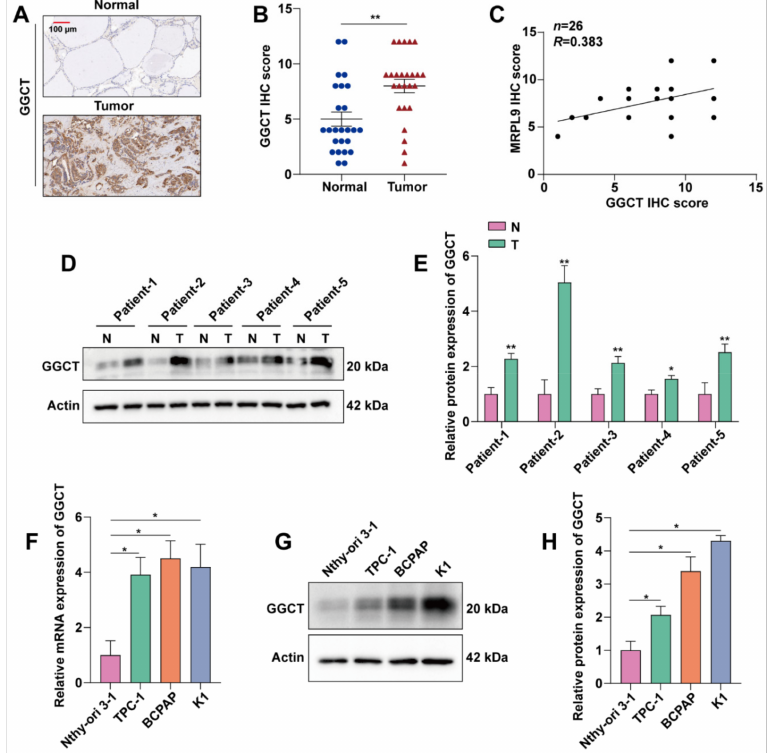
Figure 4. GGCT is highly expressed in PTC. ( A ) Representative images of GGCT immunohisto- chemistry (IHC) of normal PTC tissue (left) and PTC tissue (right) (scar bar = 100 µ m). ( B ) Statistics of GGCT immunohistochemical score of PTC group ( n = 26) and normal group ( n = 26) (Each dot represents a patient’s normal thyroid tissue, and each triangle represents a patient’s PTC tissue). ( C ) Correlation analysis of GGCT and MRPL9 IHC scores. ( D ) Representative Western blot of GGCT protein in 26 pairs of PTC tissues and normal tissues. ( E ) Western blot results were quantified and normalized to Actin ( n = 3). ( F ) RT-qPCR analysis detected the expression level of GGCT in Nthy-ori 3.1, TPC-1, K1, BCPAP cell lines ( n = 3). ( G ) Western blot detection of GGCT protein